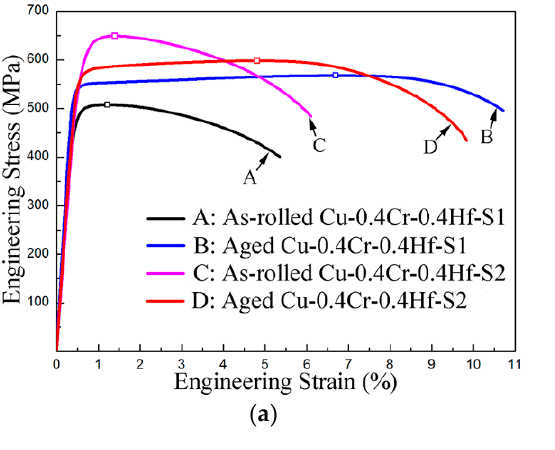
Figure 3. ( a ) Typical tensile curves of the as-rolled and aged Cu-0.4Cr-0.4Hf alloys; ( b ) strain hardening rate curves of the as-rolled and aged Cu-0.4Cr-0.4Hf alloys.